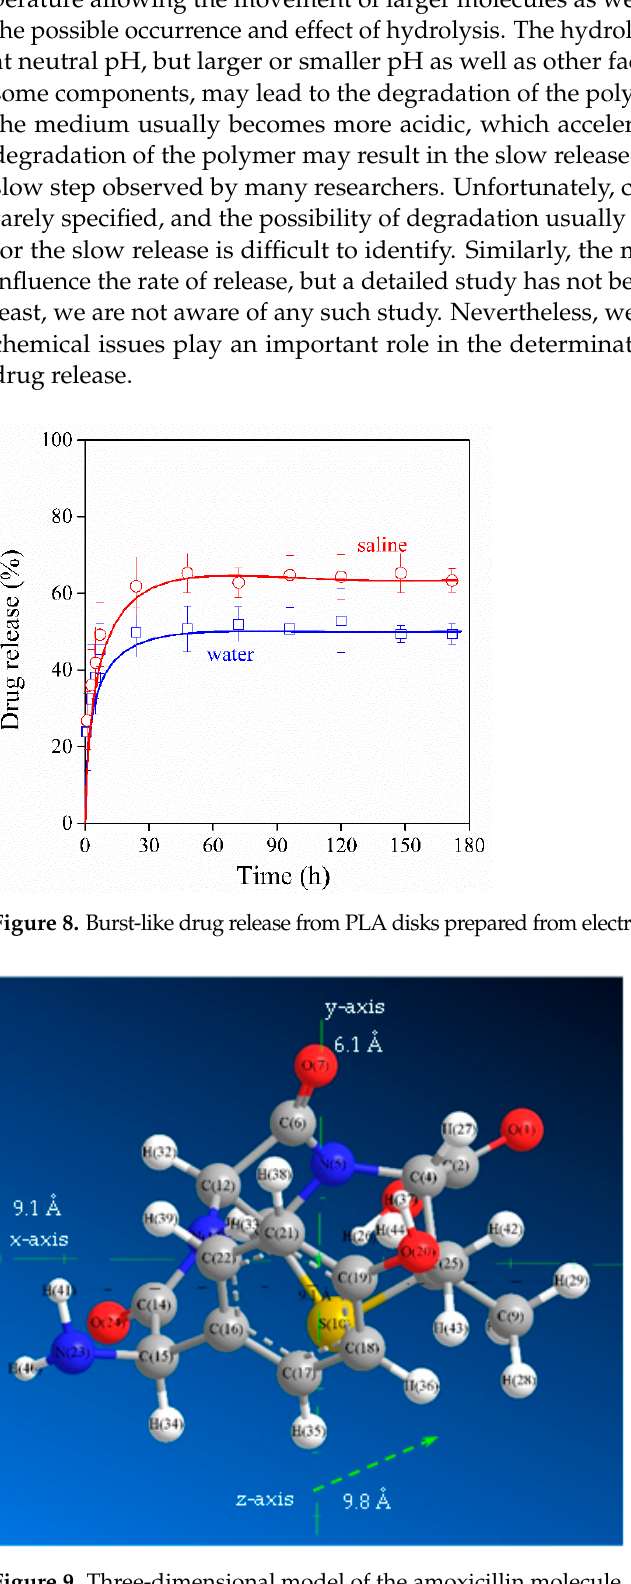
Figure 9. Three-dimensional model of the amoxicillin molecule. Determination of dimensions and the cuboid volume of one